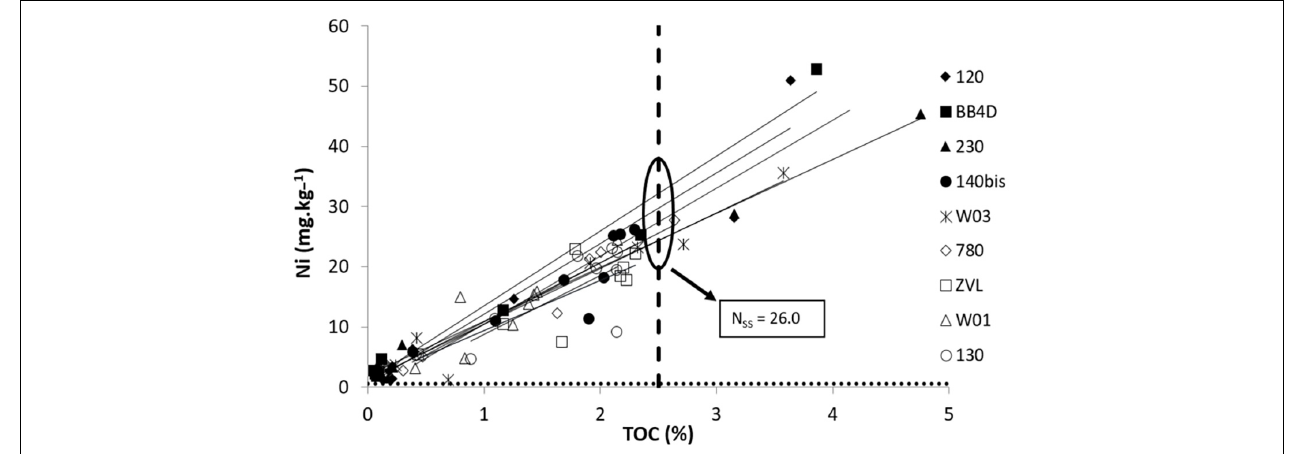
FIGURE 4 | Regression lines of equally polluted samples for Ni vs. TOC to determine Nss (at TOC